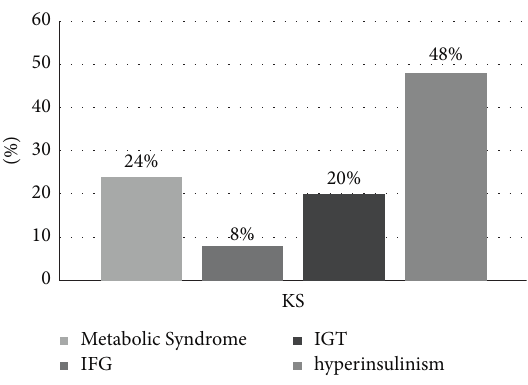
Figure 1: Prevalence of metabolic alterations in the subjects with KS examined. IFG, impaired fasting glucose; IGT, impaired glucose